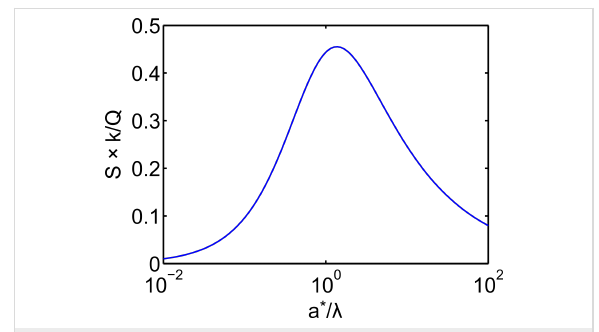
Figure 2: Plot of the normalized force sensitivity S × k / Q versus normalized amplitude a */ λ , where λ is the characteristic length scale of the interaction. The maximum of S occurs at a * ≈ λ